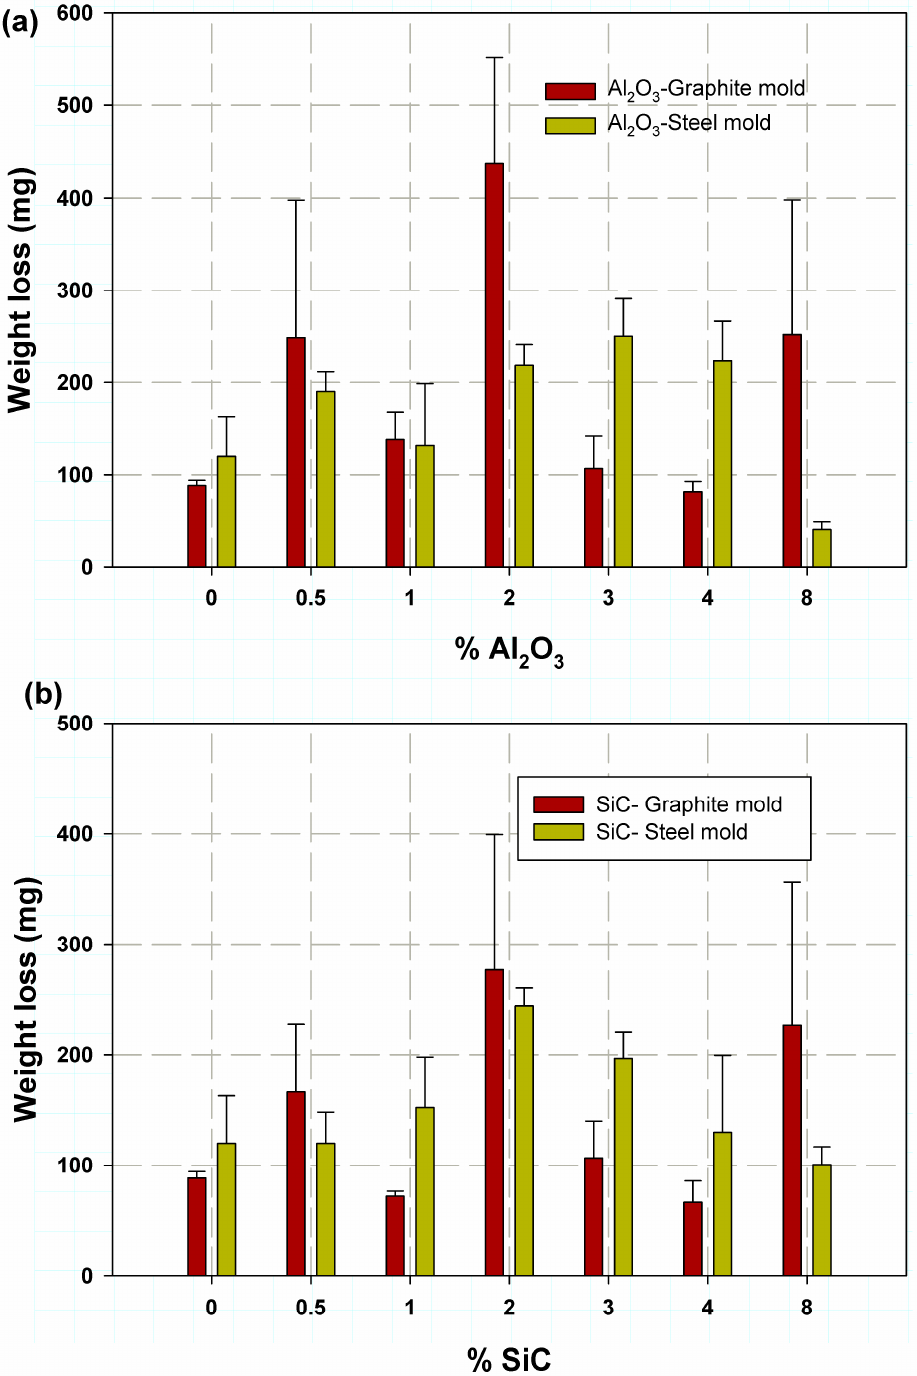
Figure 11. Average weight loss variation at 5 m/min velocity for Al-Si-Mg alloy filled with ( a ) Al 2 O 3 , ( b ) SiC.